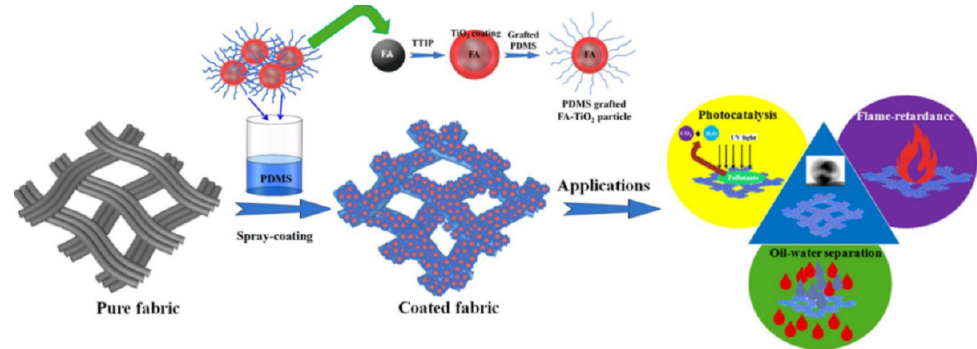
Figure 1. Multifunctional properties of a fly ash-TiO 2 -PDMS spray coated superhydrophobic fiber. Reproduced with permission from [12]. Copyright 2020 Elsevier.